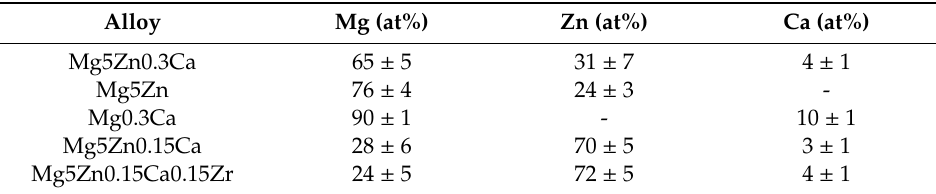
Table 2. Chemistry of the precipitates revealed by EDS.